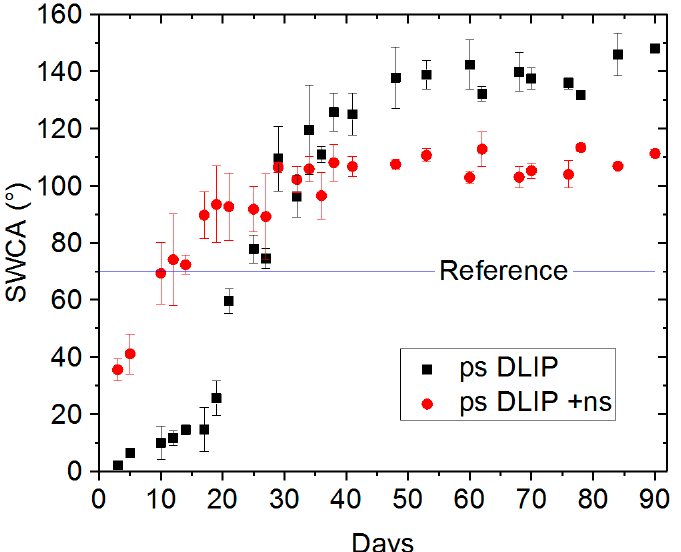
Figure 5. Water contact angle measurements over time of the multi-scale pillar-like structures (ps-DLIP) and single-scale patterns (ps-DLIP + ns). The spatial period Λ of the pillars was 5.5 µ m. For the ps treatment, a fluence F = 0.74 J / cm 2 and an overlap of 99% were used. Each data point is an average of four static water contact angle (SWCA) measurements, the error bars were estimated by their standard deviation. After each measurement, the samples were stored under normal ambient-pressure conditions.